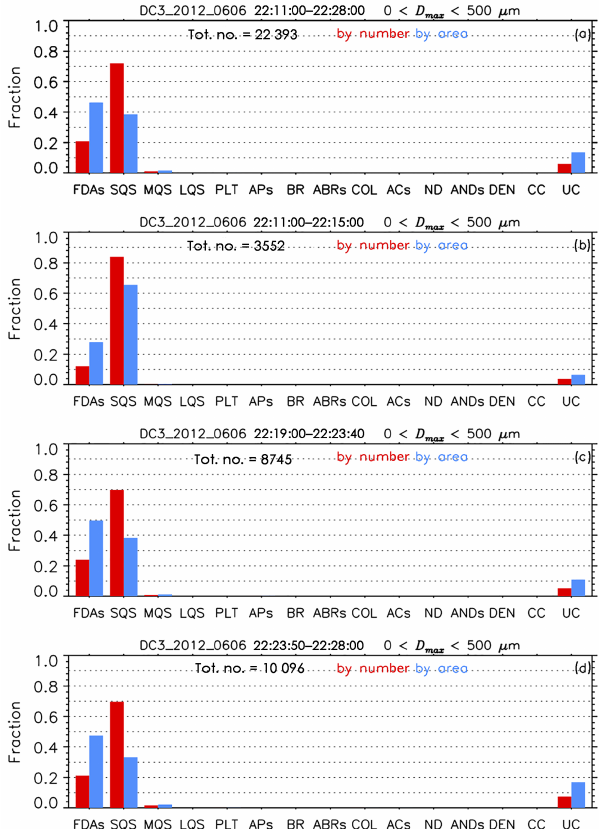
Figure 3. Contributions of ice crystal habits by number (red) and by projected area (blue) during (a) all periods, (b) period 1, (c) pe- riod 2, and (d) period 3. The total number of samples is indicated in each panel. Acronyms for crystal habits are indicated in the caption of Fig.